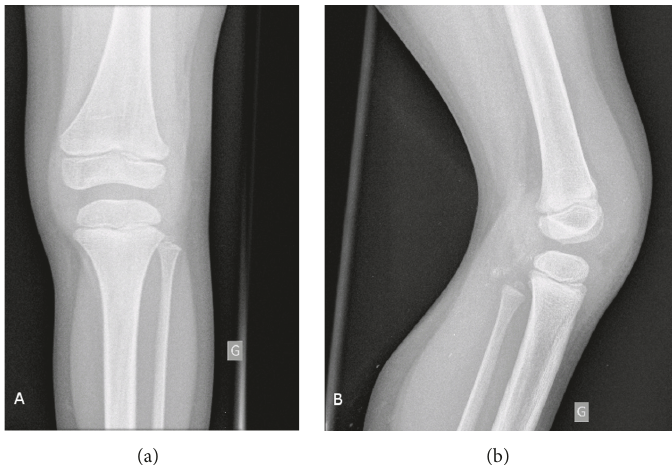
Figure 1: Plain, anteroposterior (a) and lateral (b) radiographs of a 6-year-old male patient’s left knee showing hypoplasia of the tibial intercondylar eminence and of the femoral intercondylar notch.